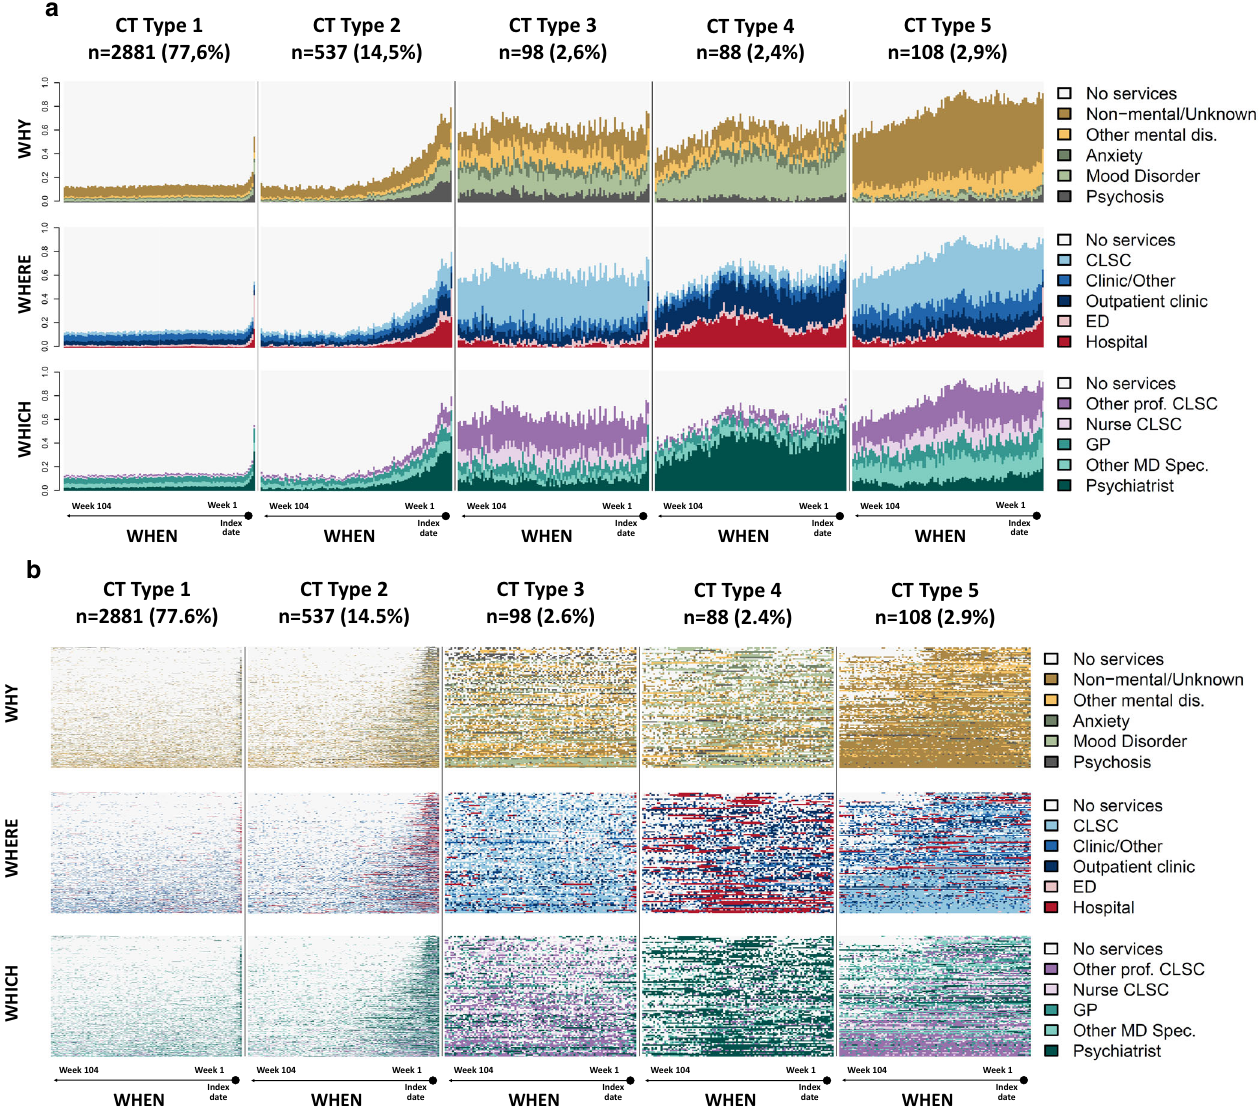
Fig. 2 State distribution plots ( a ) and sequence index plots ( b ), of the typology of care trajectories (CTs) by dimension (why, where and which), using simple Hamming as the distance measure and HCA as the clustering method. State distribution plots show the distribution of states (proportion) for each time unit point (104 weeks) prior the fi rst diagnosis of SCZ. In sequence index plots, each line represents an individual ’ s CT